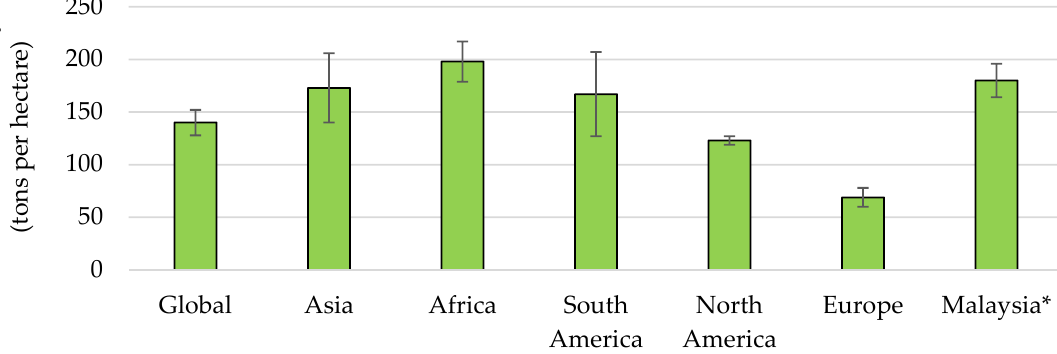
Figure 3. Comparison of forest biomass carbon density in Malaysia with different continents (the error bars represent the range of forest carbon density). Adapted from Yingchun et al. [23] and * Saatchi et al. [22].